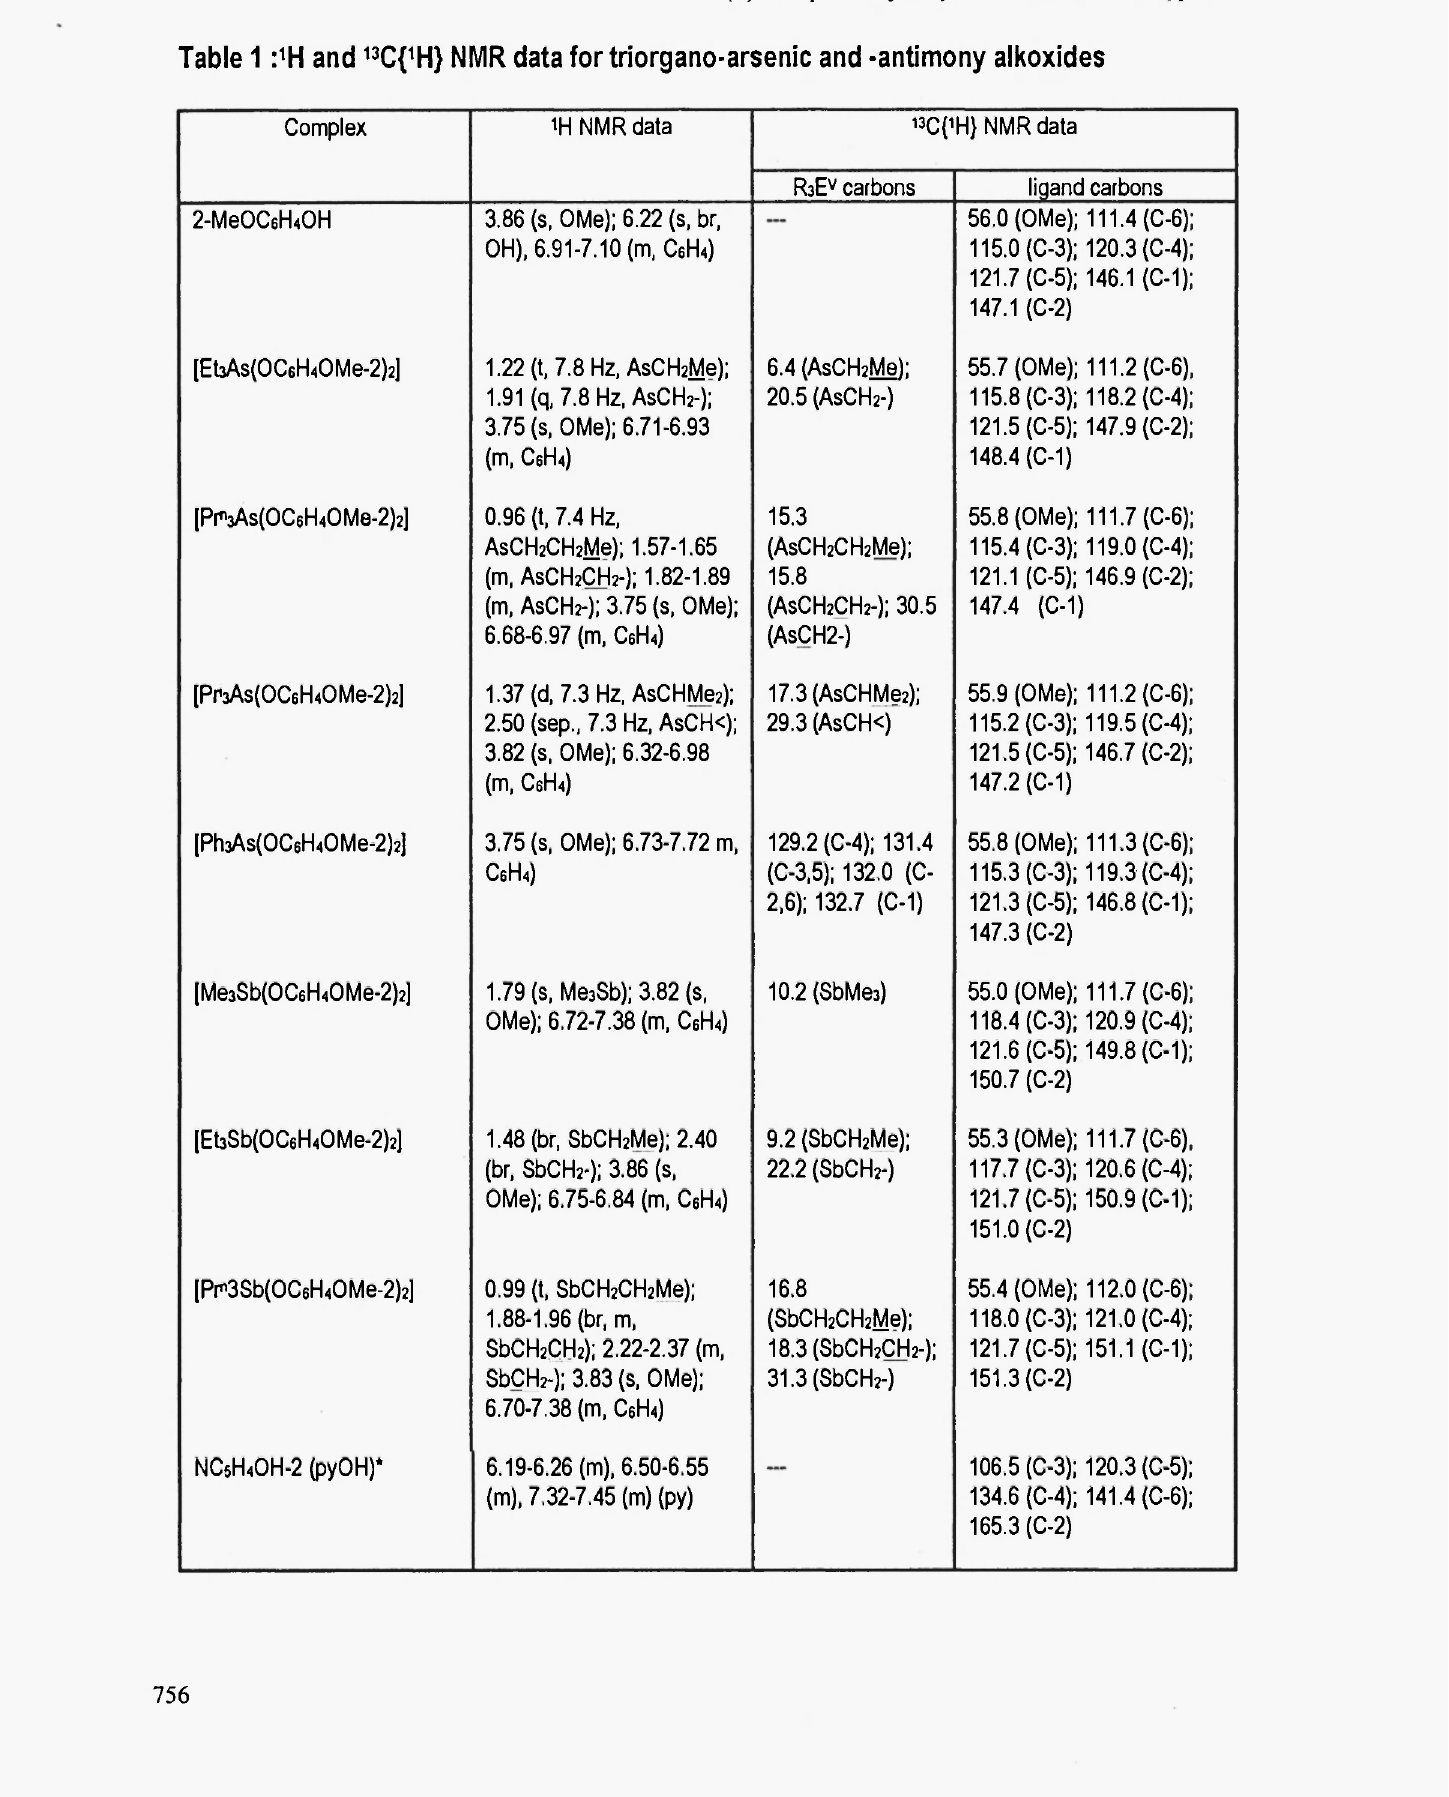
Table 1: 1 H and 13 C{ 1 H} NMR data fortriorgano-arsenic and -antimony alkoxides